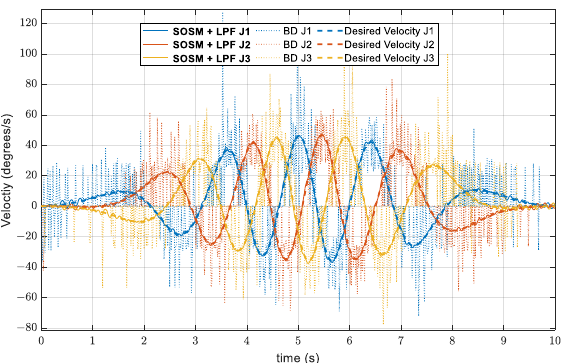
Figure 11. Desired and estimated velocities using BD and SOSM + LPF techniques.